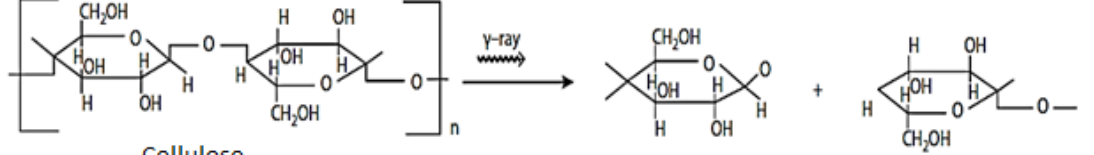
Figure 9: (a) Chain scission mechanism of cellulose during γ irradiation